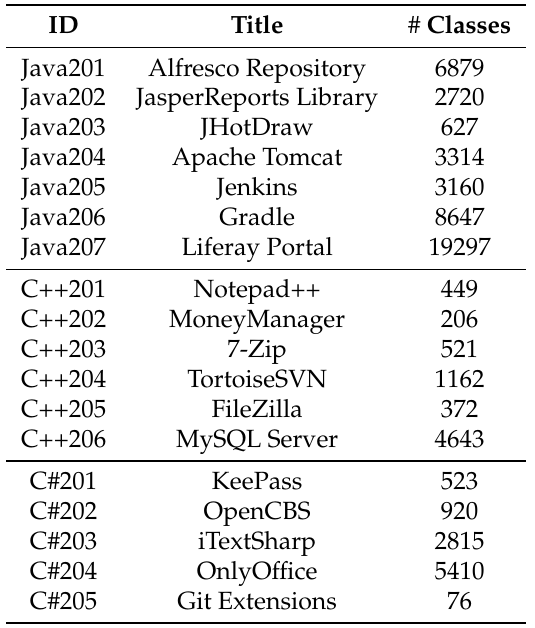
Table 2. Evaluated software within the implemented